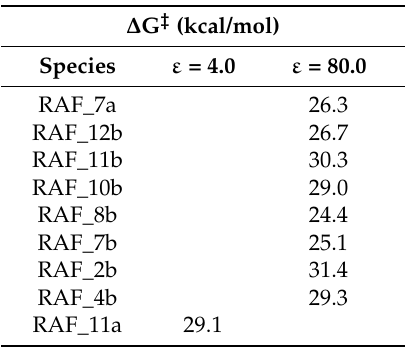
Table 4. Gibbs free activation energy values for exergonic radical adduct formations between Vam3 and · OOH free radical at 298.15